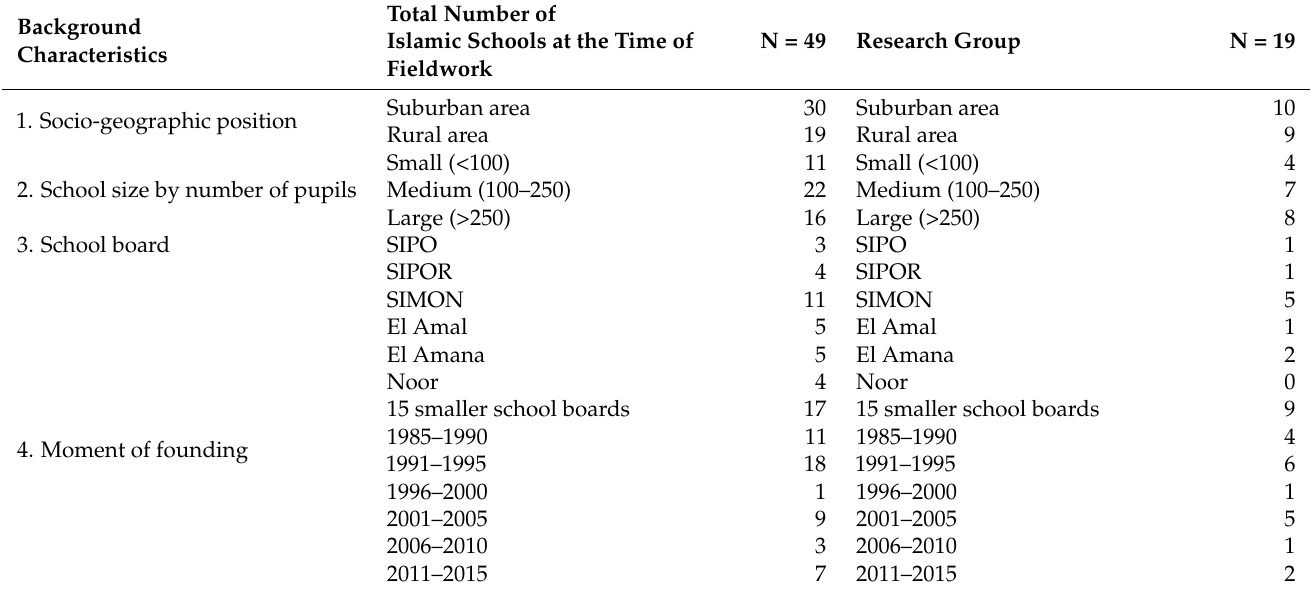
Table 3. Background data on